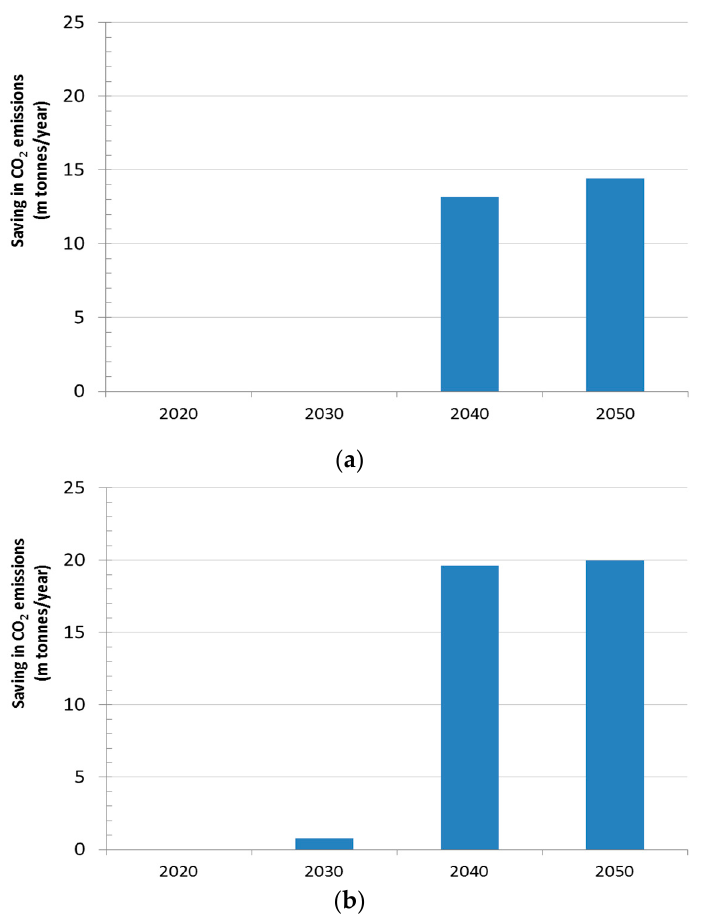
Figure 10. Reduction of carbon emissions resulting from deployment of PSPs. ( a ) Low RES scenario; ( b ) High RES scenario.